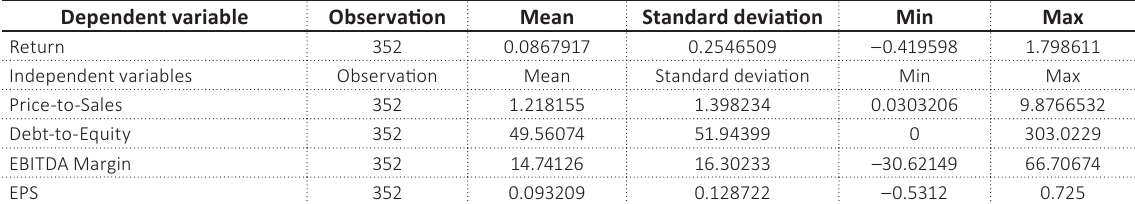
Table 1. Descriptive statistics of the variables in the sample